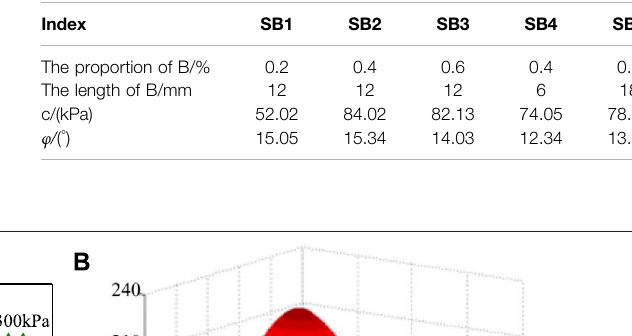
TABLE 7 | Shear strength index of SB mixed